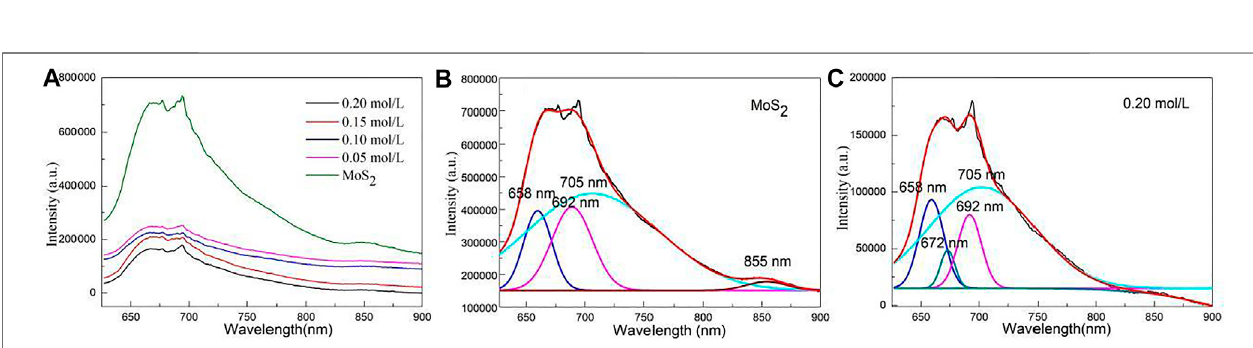
FIGURE 6 | (A) Emission spectra of MoS 2 /C composites prepared by the hydrothermal calcination method with the different concentrations of molybdenum chloride including 0, 0.05, 0.10, 0.15, and 0.20 mol/L. (B) Emission spectrum of pure MoS 2 could be resolved into three Gaussian peaks with the maxima at 658, 692, 705, and 855 nm. (C) Emission spectrum of MoS 2 /C composites with the concentration of molybdenum chloride of 0.20 mol/L could be resolved into four Gaussian peaks with the maxima at 658, 672, 692, and 705